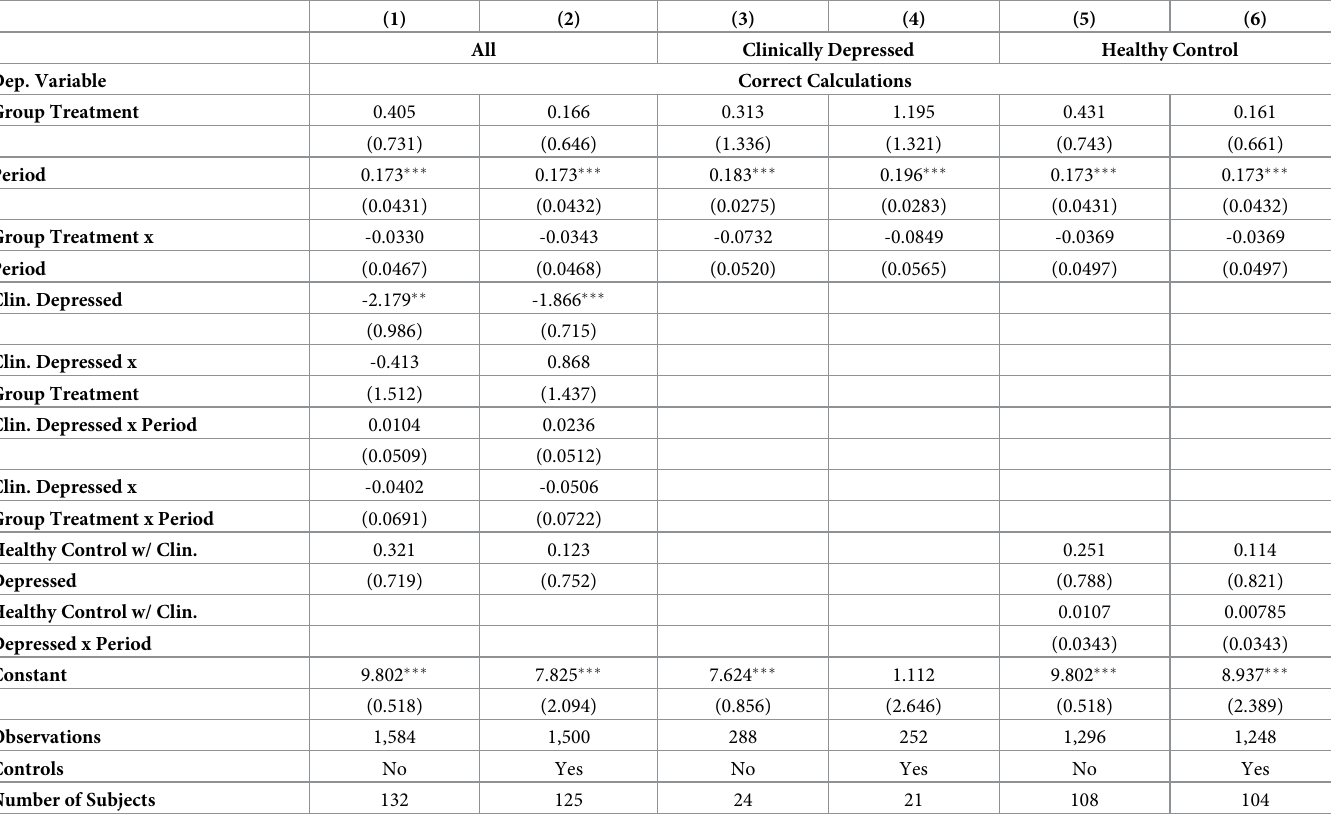
Table 12. Panel regression on correct calculations in the clinical